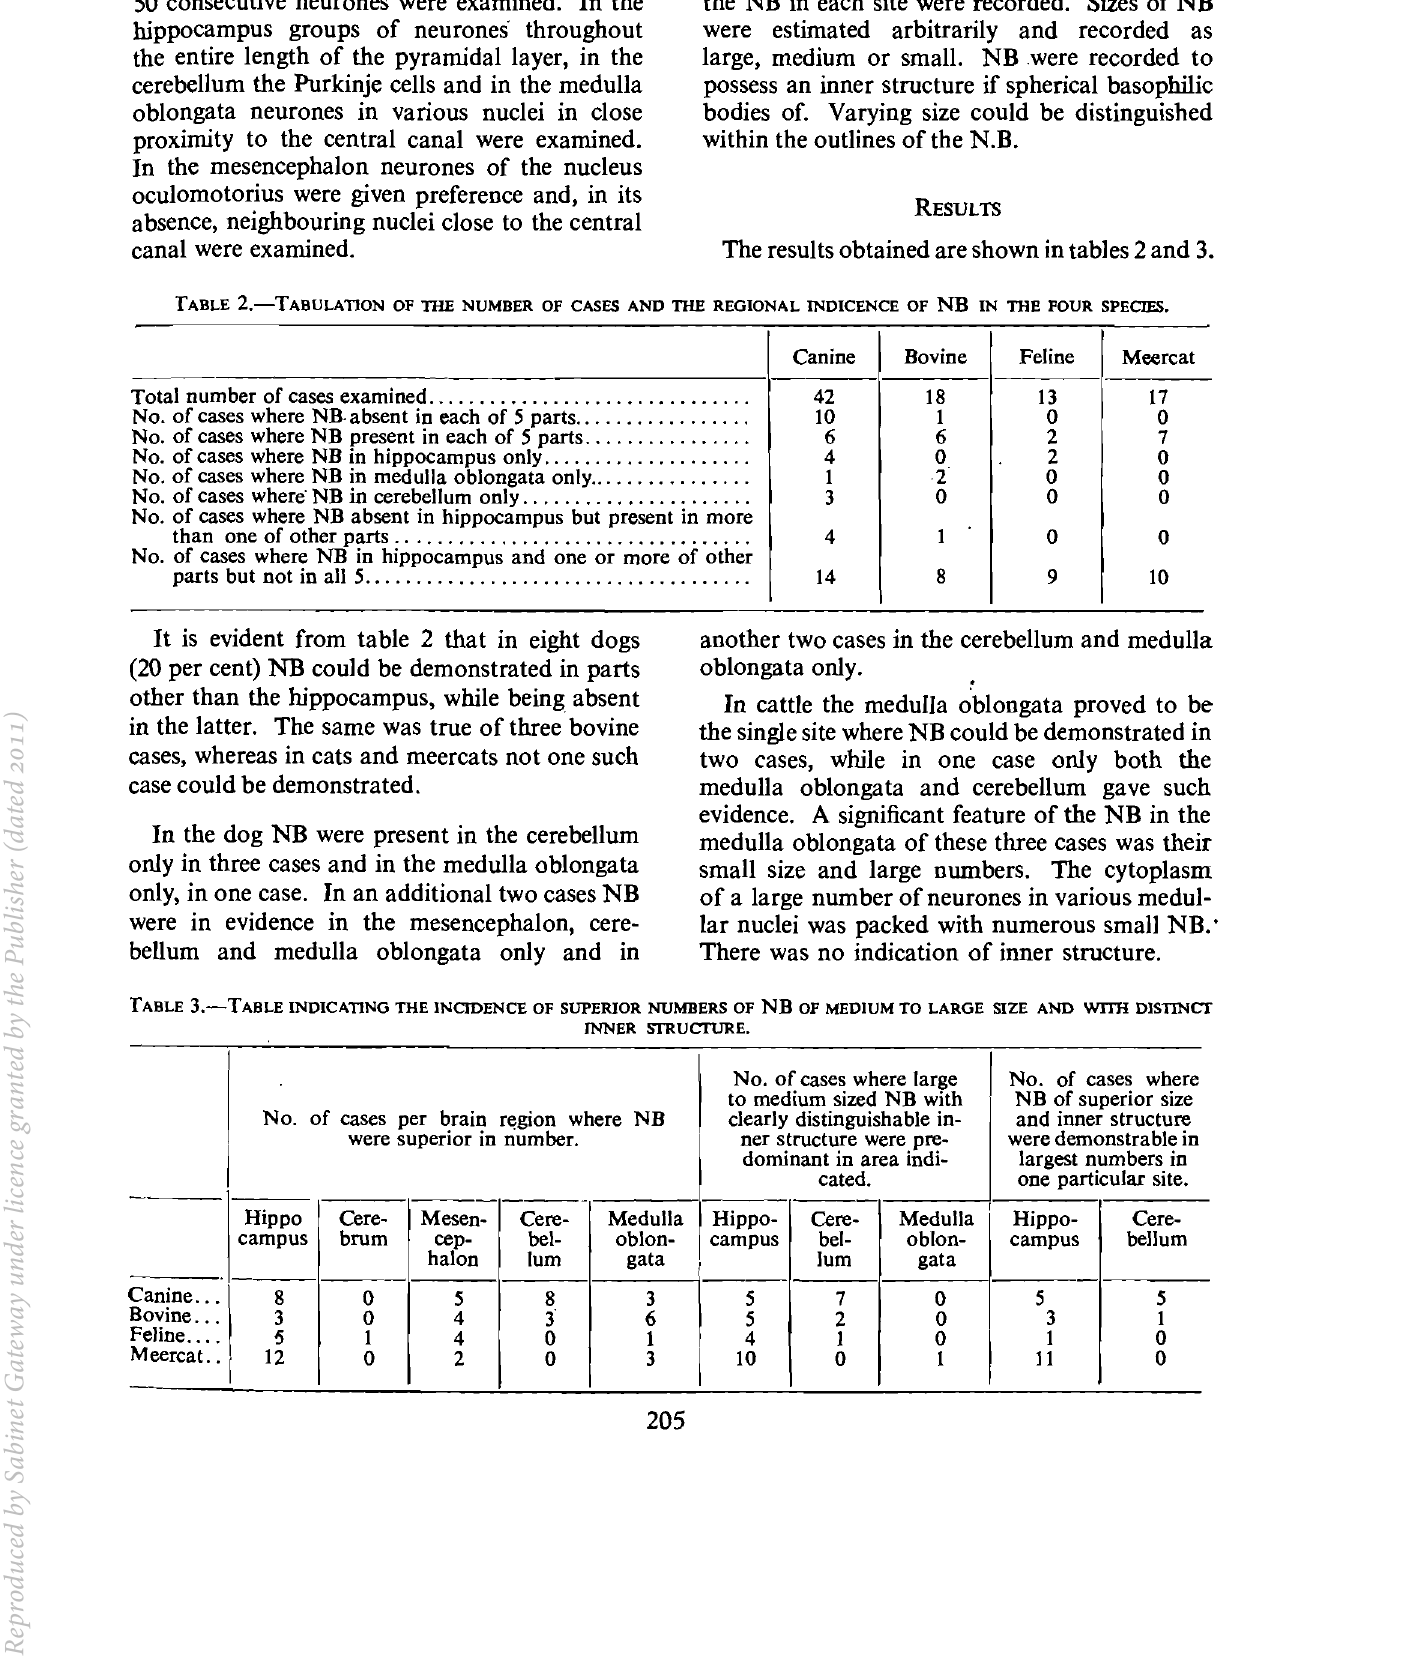
TABLE 2.-TABULATION OF THE NUMBER OF CASES AND THE REGIONAL INDICENCE OF NB IN THE FOUR SPECIES.